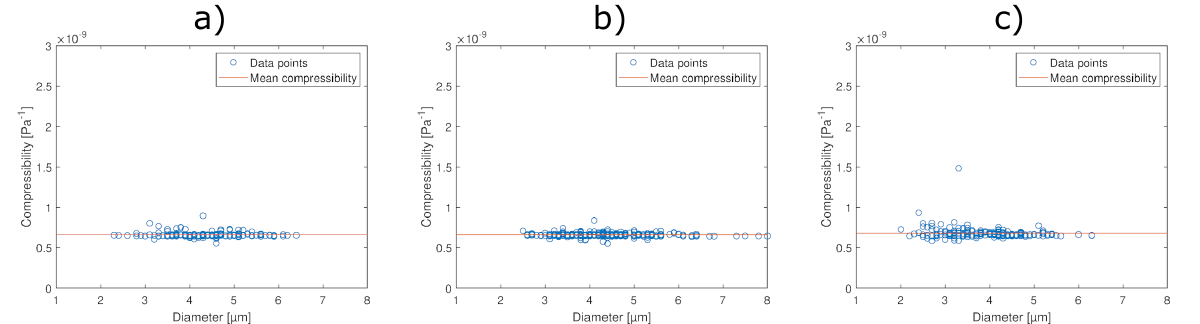
Figure 4. The compressibility of individual droplets at ( a ) 240 kPa, ( b ) 325 kPa, and ( c ) 360 kPa, where the density was set to constant based on the proportion of PFP and CNF in the preparation step and their respective densities presented in Table